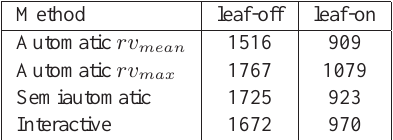
Table 3: Overview of results for all